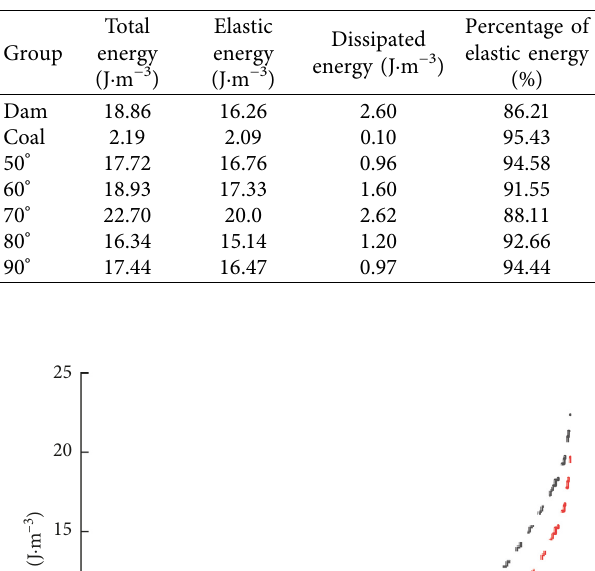
Table 4: Uniaxial compression energy value of coal pillar-artificial dam test piece.